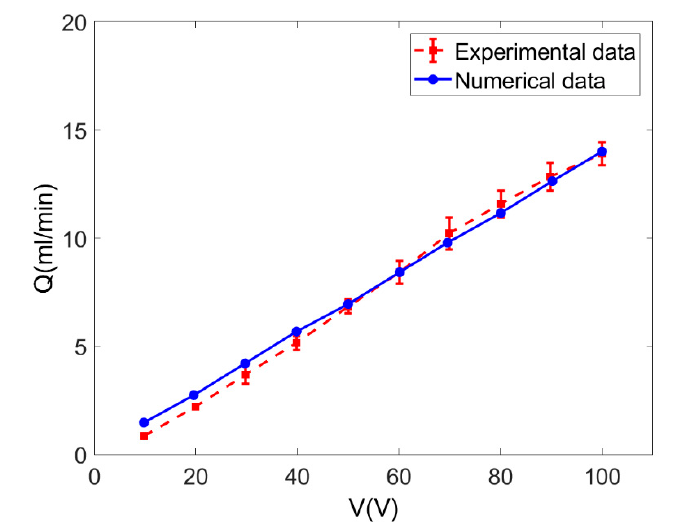
Figure 6. Comparison of the total flow rates obtained from the present model Equation (17) and the experimental data in [17] for Newtonian fluid ( c = 0.01 mol/m 3 , ζ = − 0.1 V).